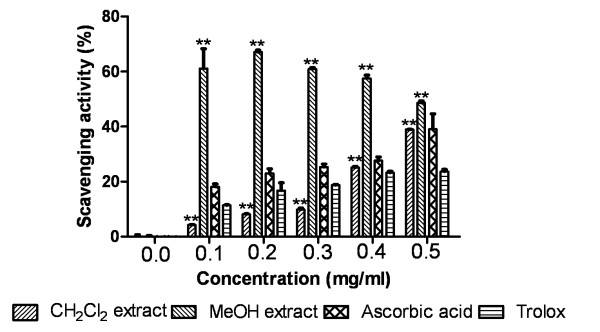
Superoxide radical scavenging activity. Effect of Dragon's blood resin extracts and standards ascorbic acid, trolox on superoxide scavenging assay. The percentage of scavenging was plotted against concentration of samples. **P < 0.0001 vs 0 μg/ml.